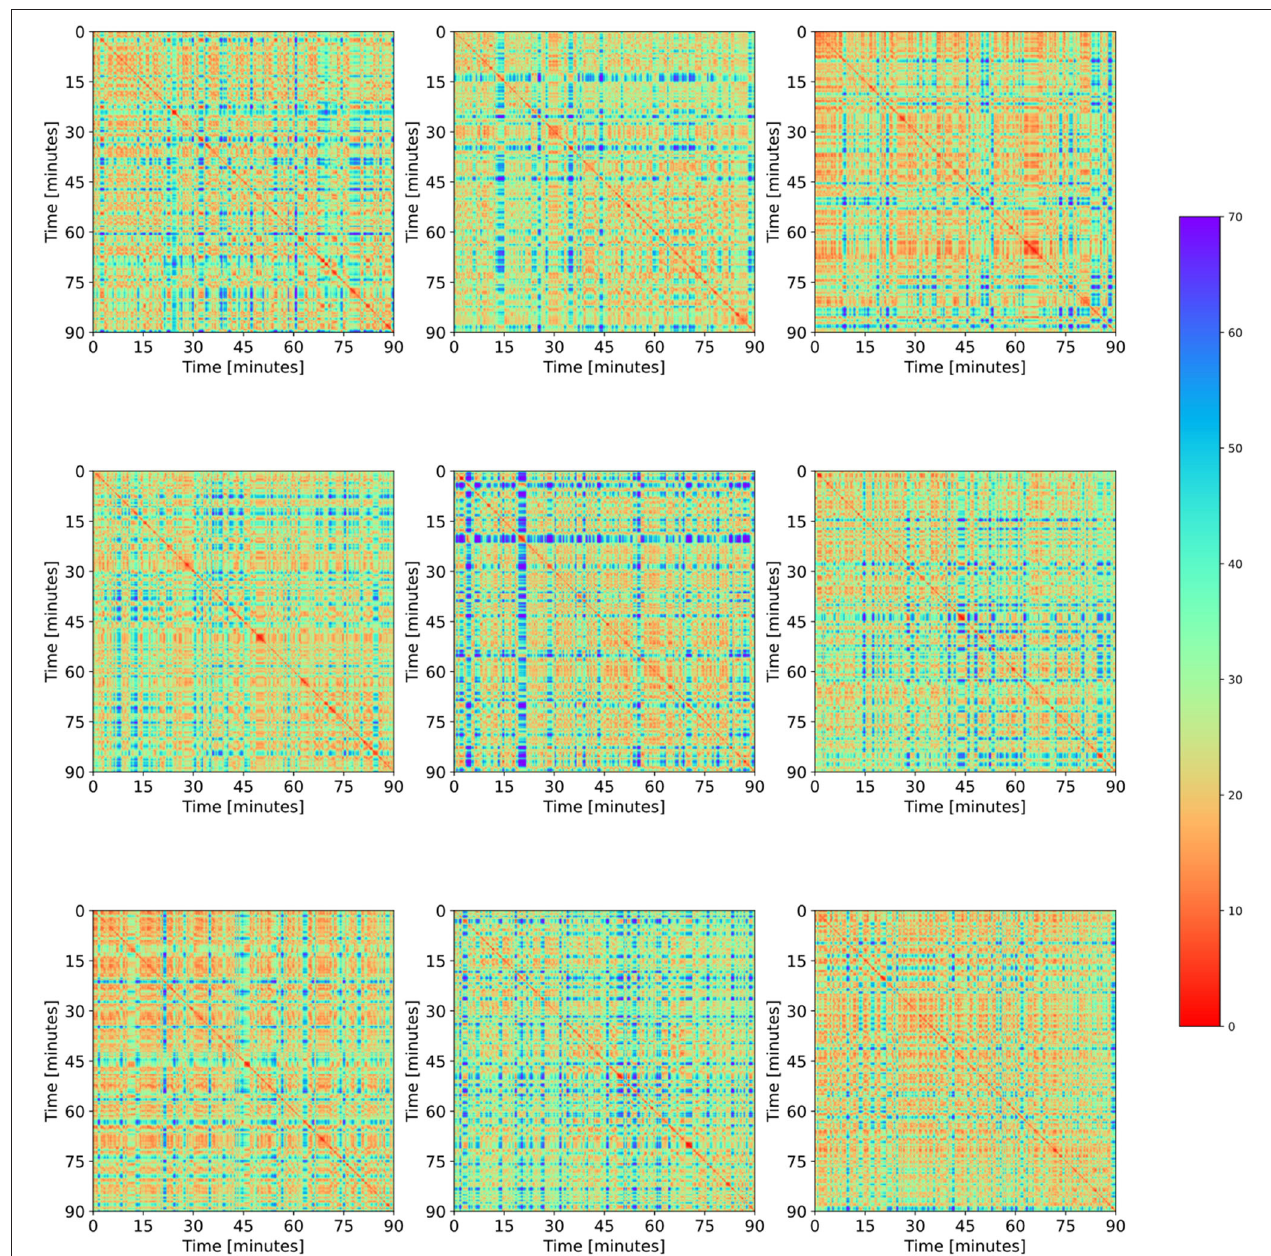
FIGURE 3 | Thumbnails of 9 arbitrarily selected RPs. The three typical elements (red diagonal stripes, blue stripes, and red/yellow rectangles) can be found in each match, whereas their frequencies, sizes, and dispersions are highly match-specific.